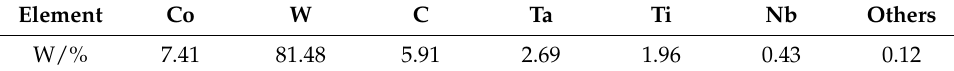
Table 1. Main chemical composition of the coated multicomponent hardmetals.